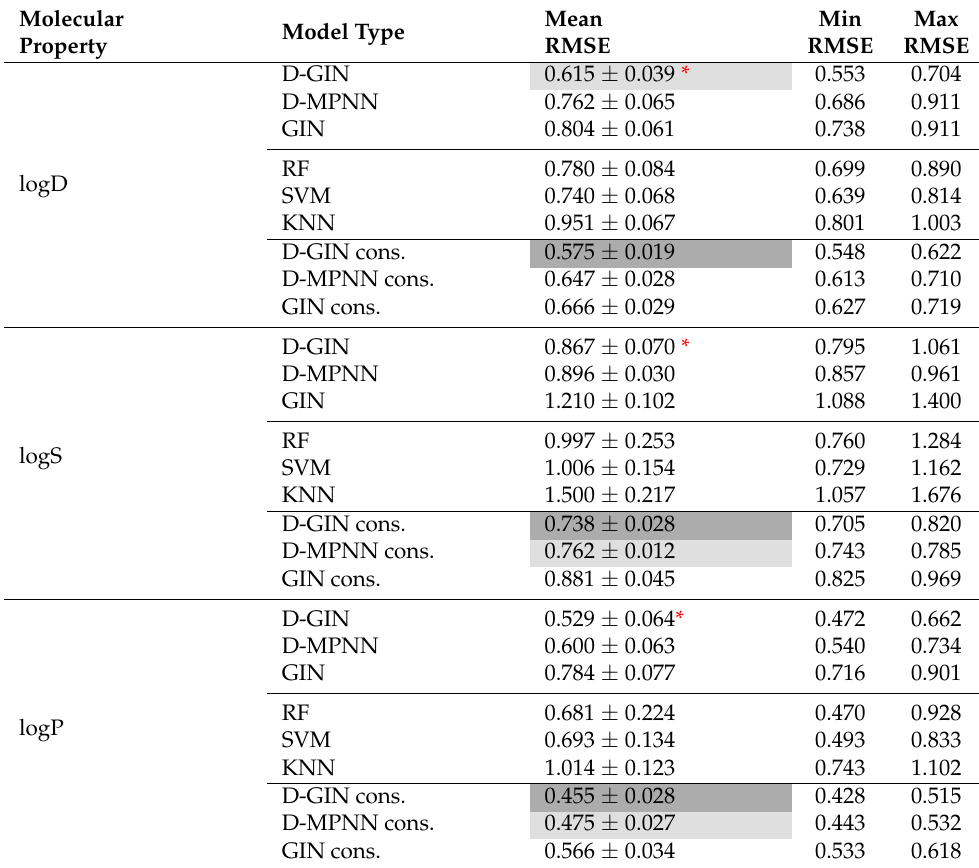
Table 2. Overview of the best performing machine learning model types independent of training and featurization strategy for prediction of logD, logS, and logP. The performance was calculated as the distribution average over all used model root mean squared error (RMSE) values. In total 24 models were used for the loD and logS property, and 12 for the logP property. RMSE values highlighted in dark and light gray show the best and next best models. Red asterisks mark the lowest RMSE for the non-consensus models for each property